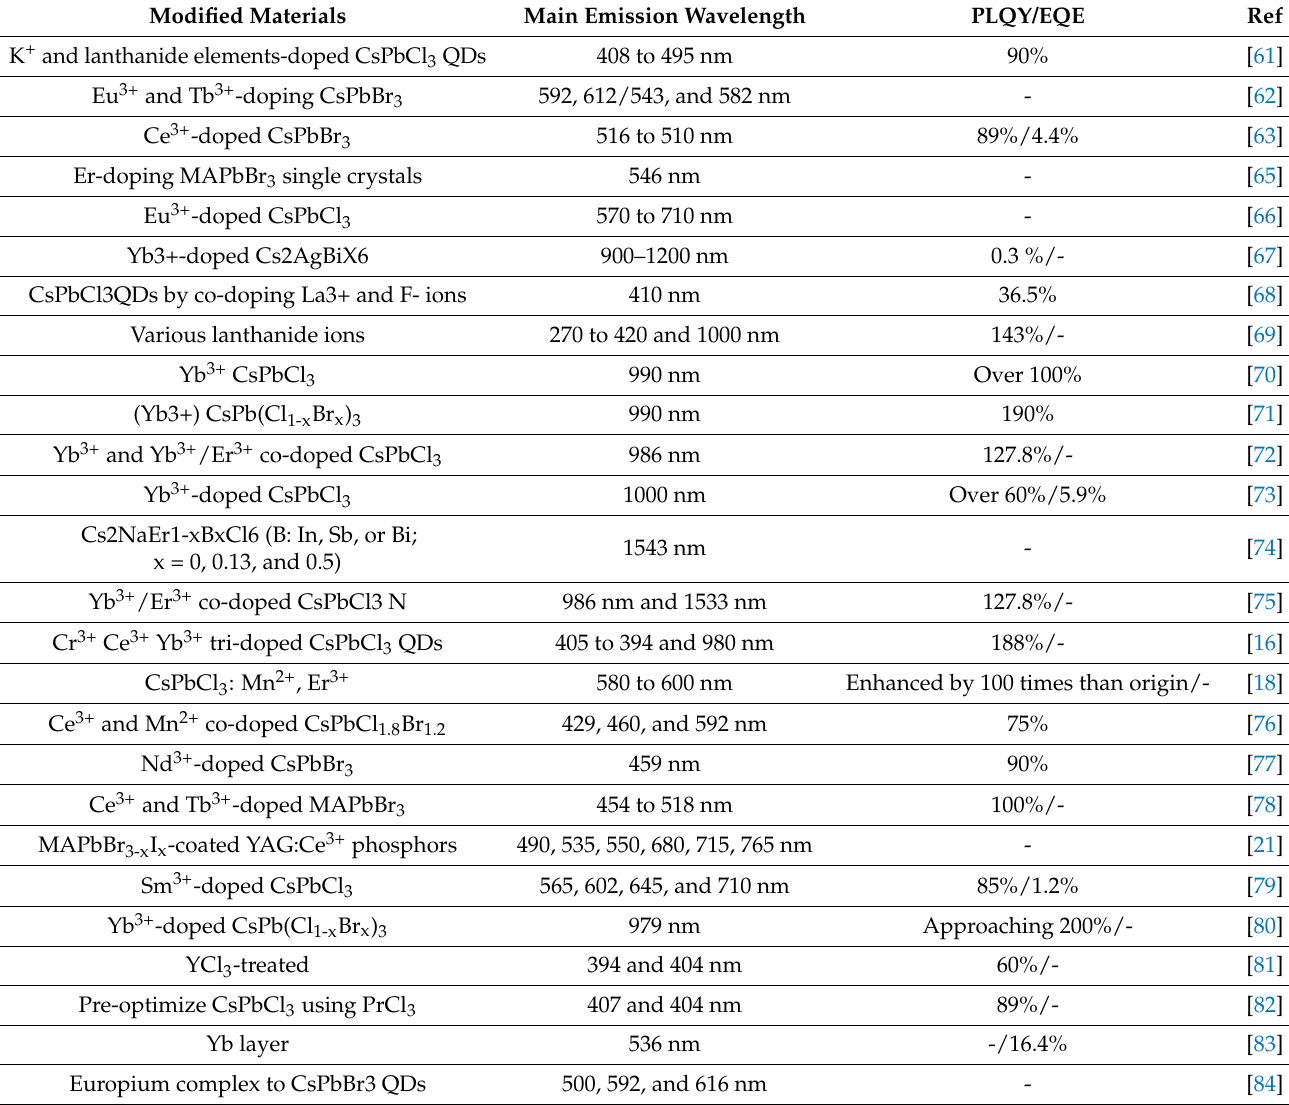
Table 3. The PLQY enhancement of Ln 3+ -doping PVK and the EQE enhancement of Ln 3+ -doping perovskite